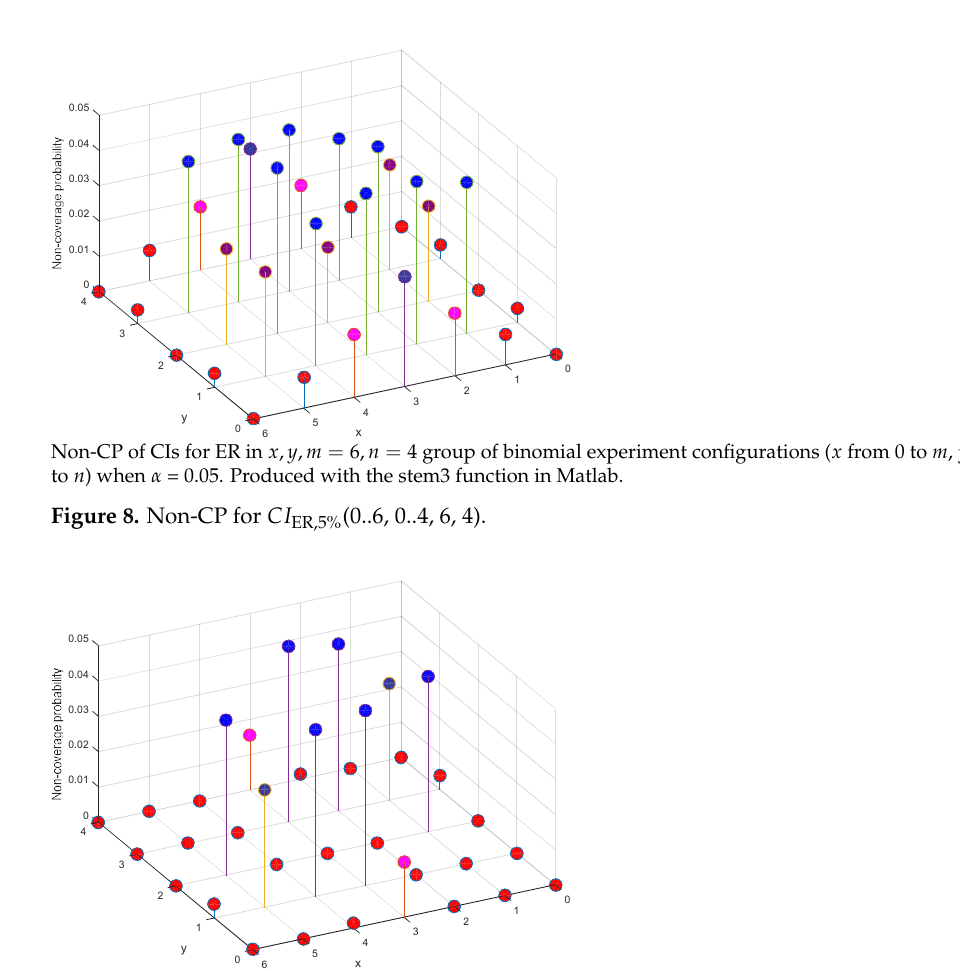
Non-CP of CIs for OR in x , y , m = 6, n = 4 group of binomial experiment configurations ( x from 0 to m , y from 0 to n ) when α = 0.05. Produced with the stem3 function in Matlab. Figure 9. Non-CP for CI OR,5% (0..6, 0..4, 6, 4).